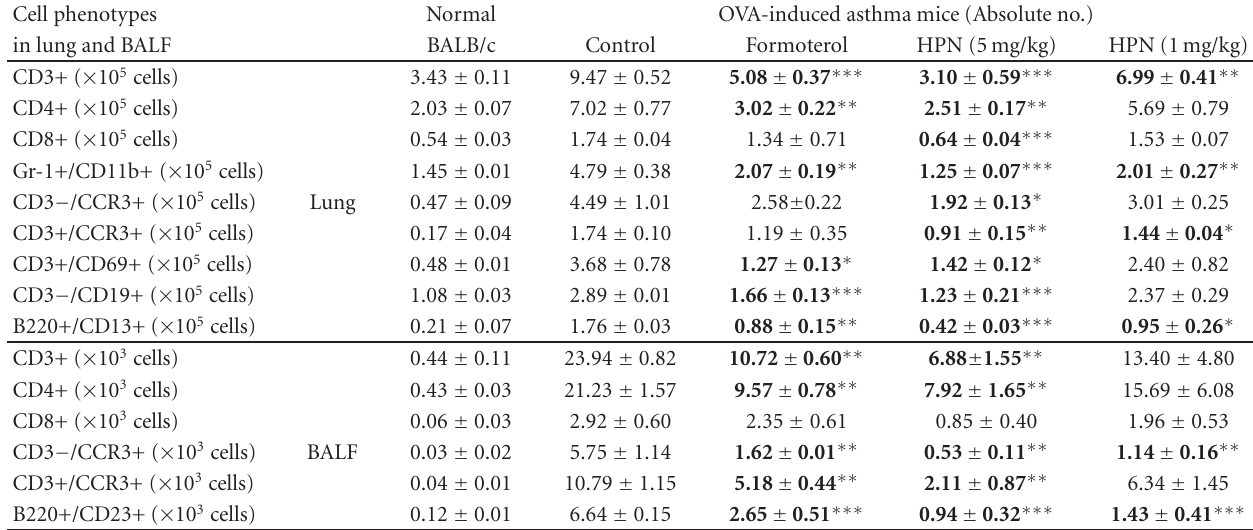
Table 1: Quantification by means of FACS analysisof various immune cell subtypes in lung and BALF. Absolute numbers of various immune cell subtypes in lung were counted (described in Section 2). Results are expressed as mean ± S.E ( N = 5). Statistical significance between control and treatment groups was assessed by ANOVA ( ∗ P < . 05, ∗∗ P < . 01, ∗∗∗ P < . 001). N : Normal BALB/c mice, CT: Ovalbumin inhalation + vehicle, formoterol: OVA + formoterol (1mg/kg), OVA + HPN (5, 1